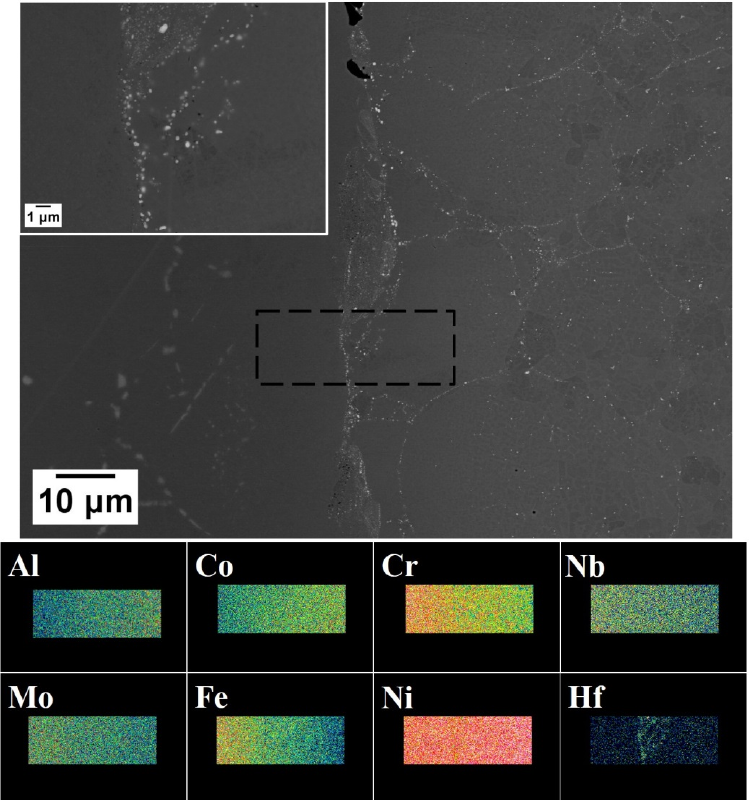
Figure 18. BSE micrographs of the boundary between the IN718 disk and the HIPped CM247LC powder, with a higher magnification BSE micrograph in the insert. X-ray maps of various elements are shown below the low magnification BSE. Micromachines 2020 , 11 , x FOR PEER REVIEW